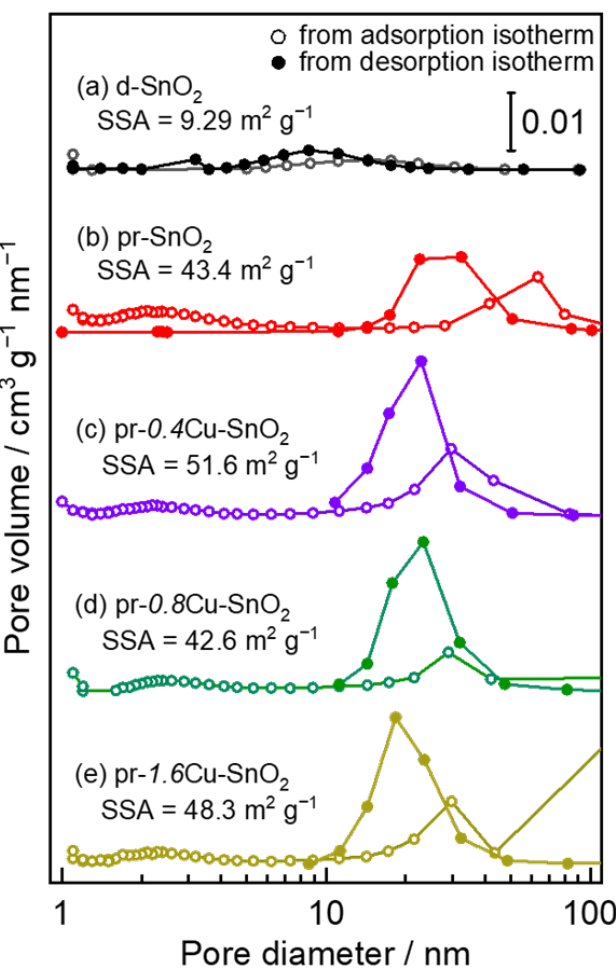
Figure 5. Pore-size distributions of as-prepared d-SnO 2 , pr-SnO 2 , and pr- w Cu-SnO 2 ( w : 0 . 4 , 0 . 8 , 1 . 6 ) powders, together with their specific surface area (SSA).